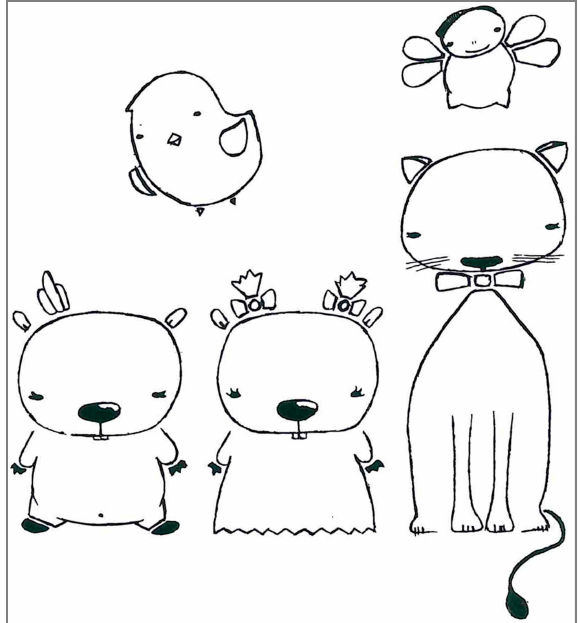
Figure 6. The protagonists of the full story: the male companion of the protagonist, a bumblebee, a cat, and a canary. All the drawings, shown born as sketches on paper, are later imported to the Adobe Illustrator application. The final version of the various subjects is reported before being sent to the printer, then heated in the oven and colored by